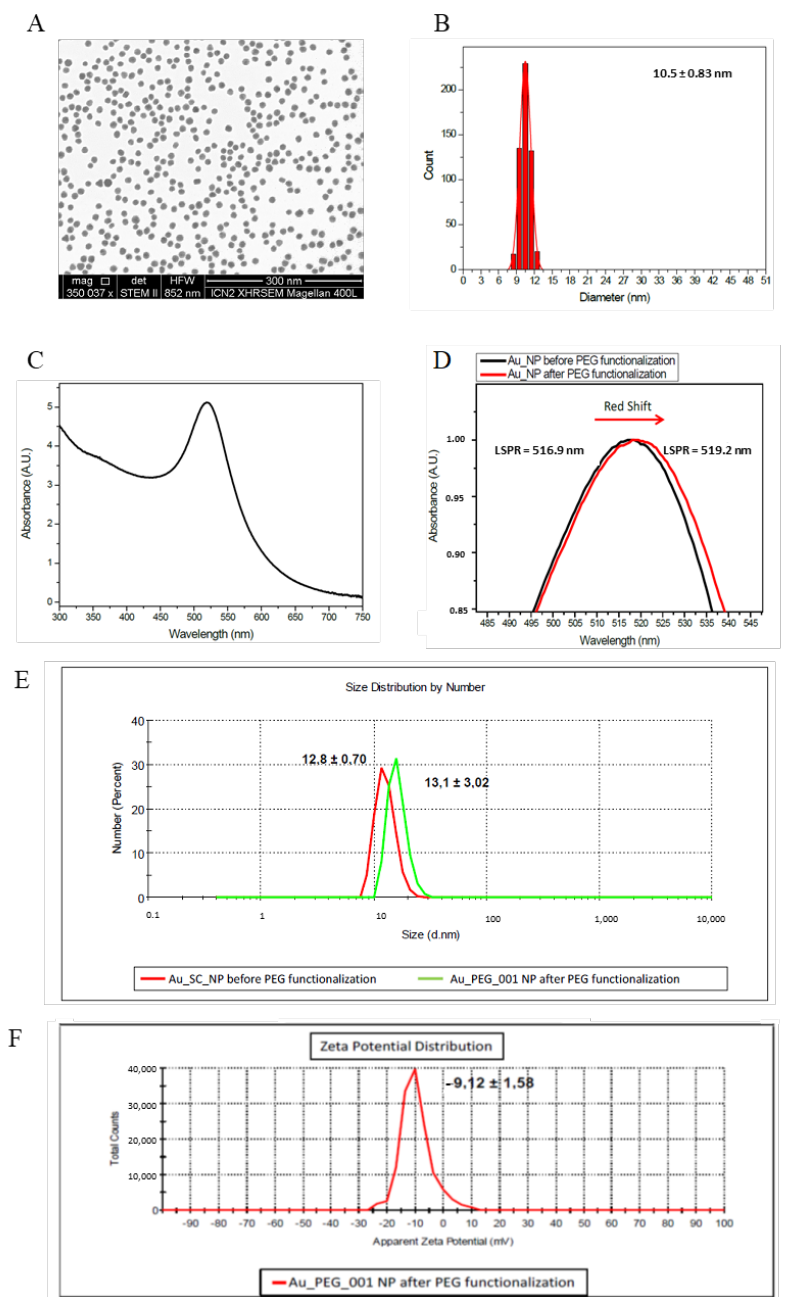
Figure 1. Basic characteristics of PEG-AuNPs. ( A ) TEM image of PEG-AuNPs; the bar represents 300 nm; ( B ) corresponding histograms of size distribution, ( C ) UV-vis spectra of the colloidal AuNPs suspension; ( D ) localized surface plasmon resonance (LSPR) of PEG-AuNPs; ( E ) hydrodynamic diameters measured by dynamic light scattering (DLS) for AuNPs and PEG-AuNPs, ( F ) zeta potential distribution of PEG-AuNPs.